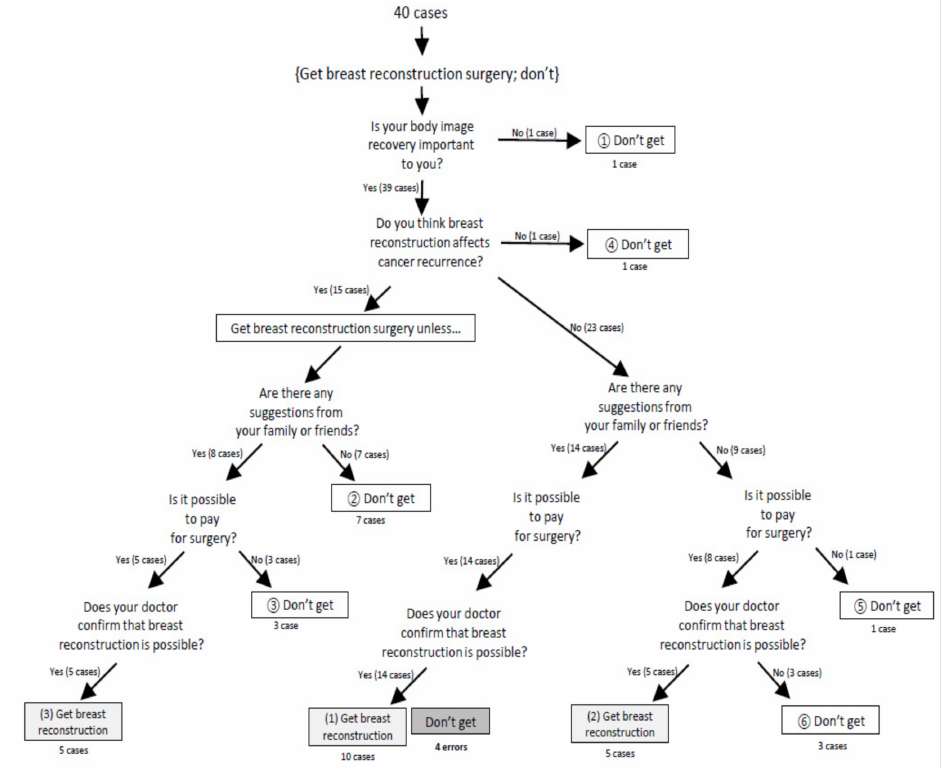
Figure 3. Final decision tree model for breast